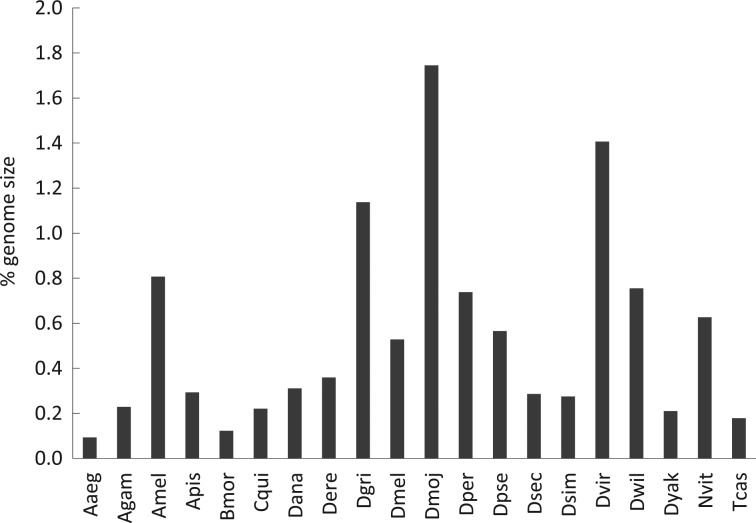
Imperfect microsatellites as the percentage of genome size of insects. The insect names (abbreviated) are shown in the x-axis and the percentages are shown in the y-axis.